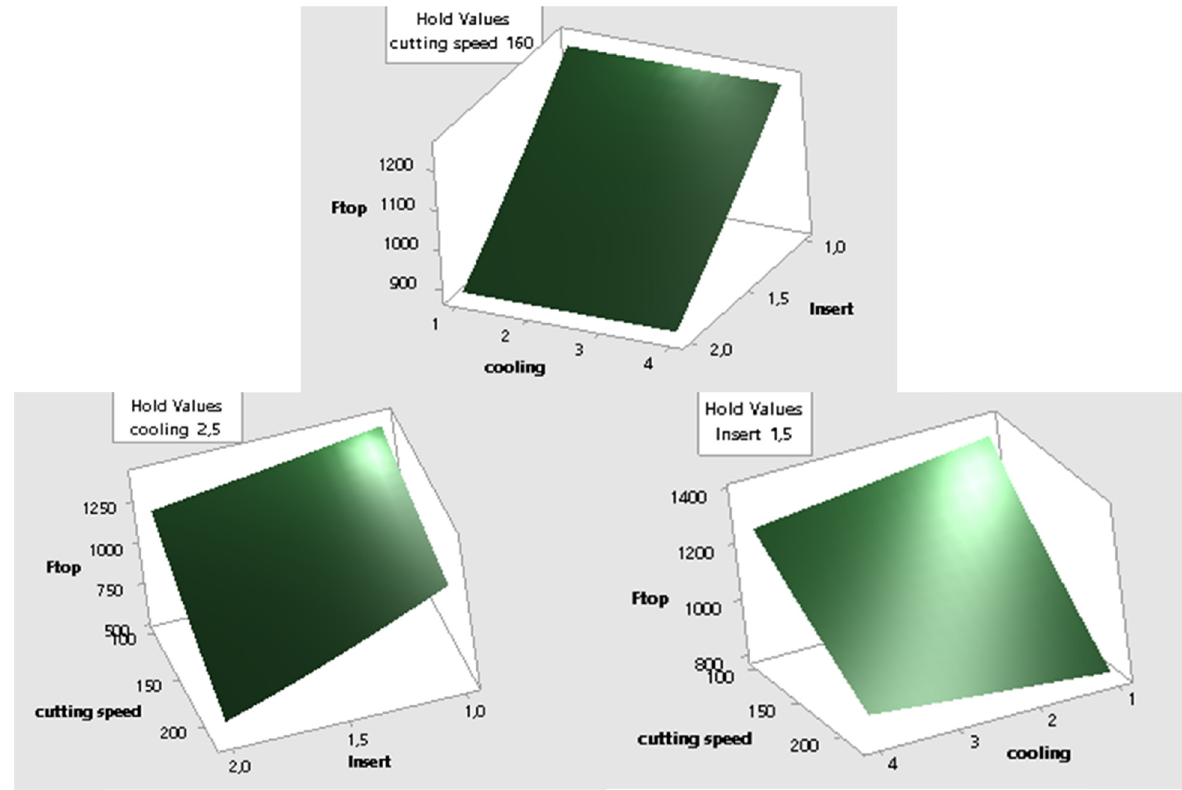
Figure 3: Relation of resultant cutting forces with machinability parameters.